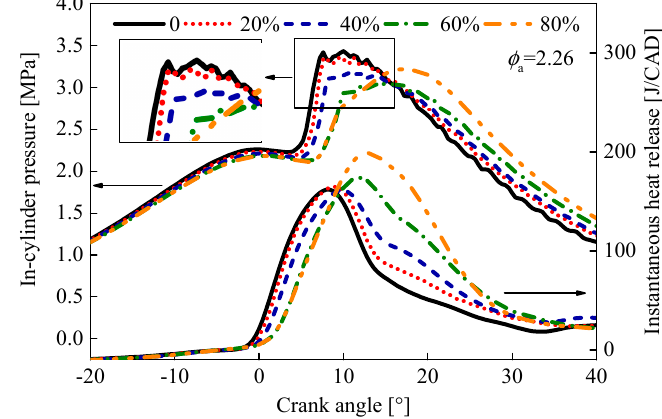
Figure 5. Comparison of in-cylinder pressure and HRR under different substitution rates at ϕ a = 2.26.